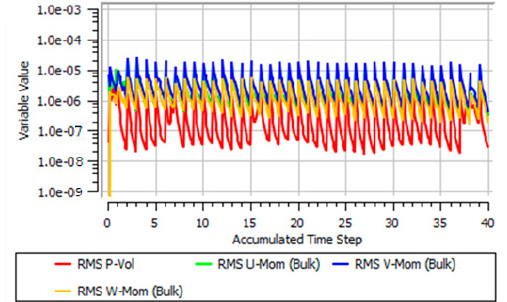
Appl. Sci. 2022 , 12 , x FOR PEER REVIEW